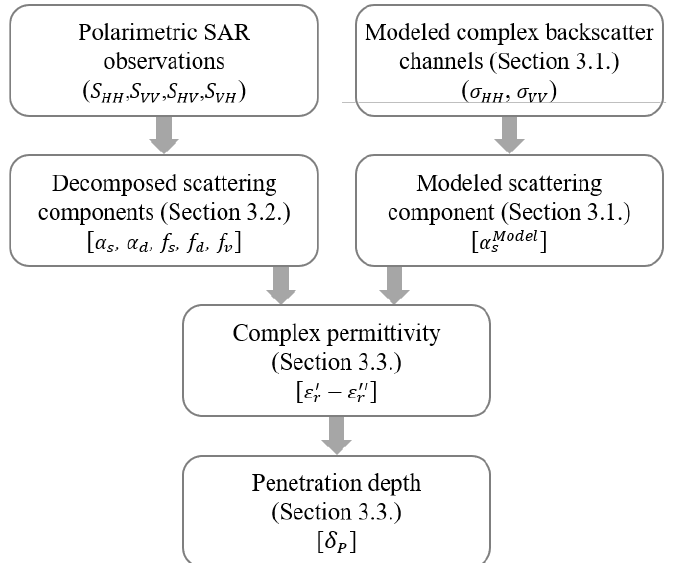
Figure 3. Flow chart of the proposed P-band SAR moisture estimation method for complex soil permittivity and penetration depth estimation based on decomposed scattering components.